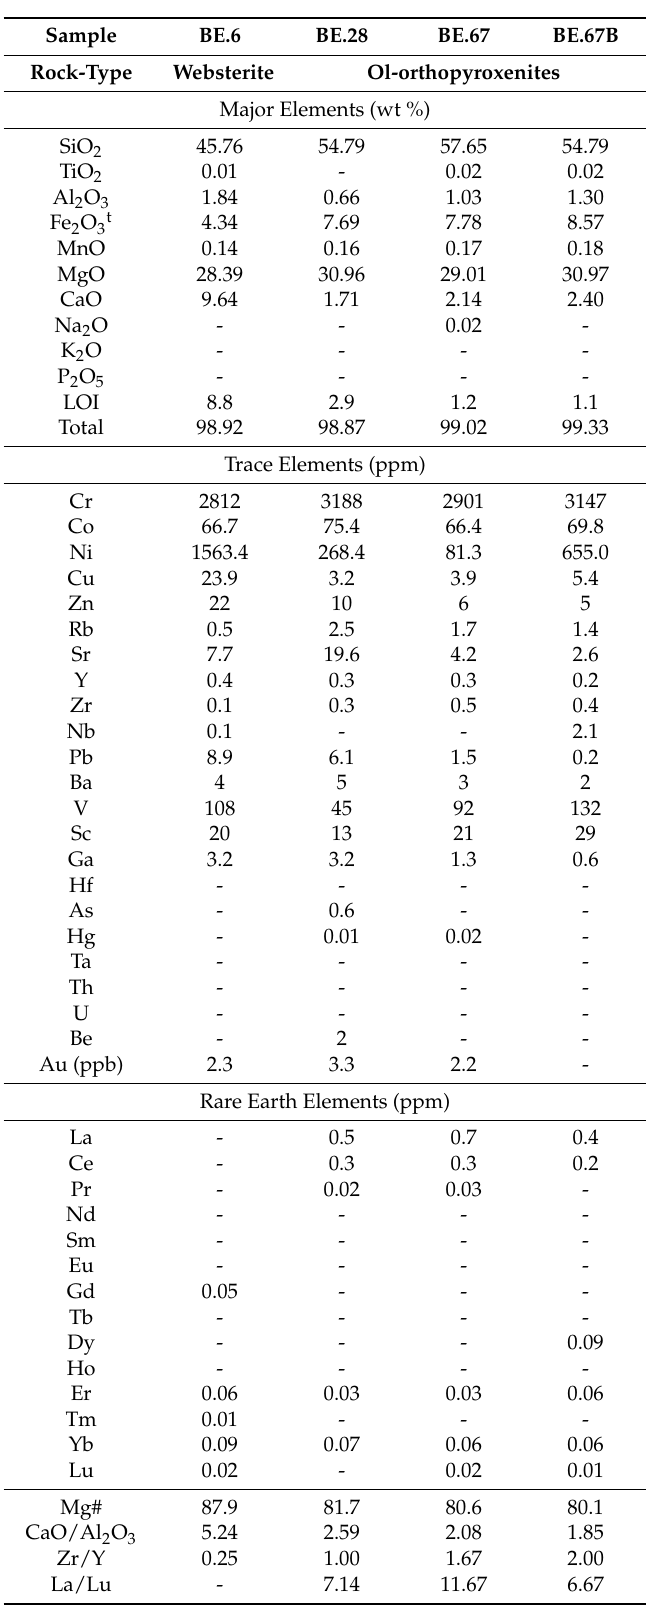
Table 5. Representative geochemical analyses of pyroxenites from Veria-Naousa ophiolite (-: below detection